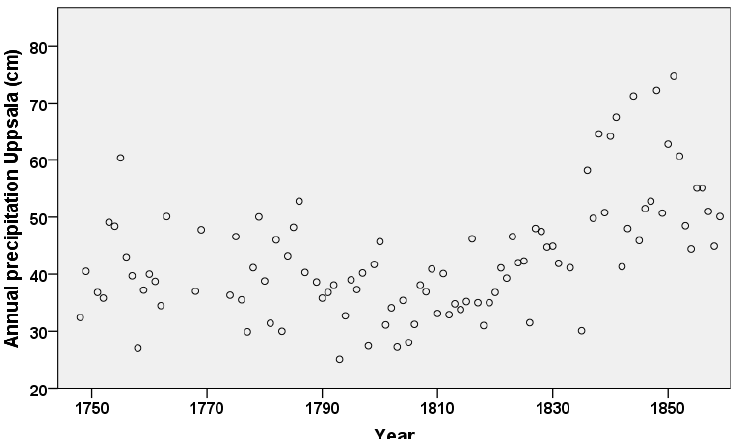
Figure 3. Annual precipitation (cm), Skellefteå 1749–1859 .